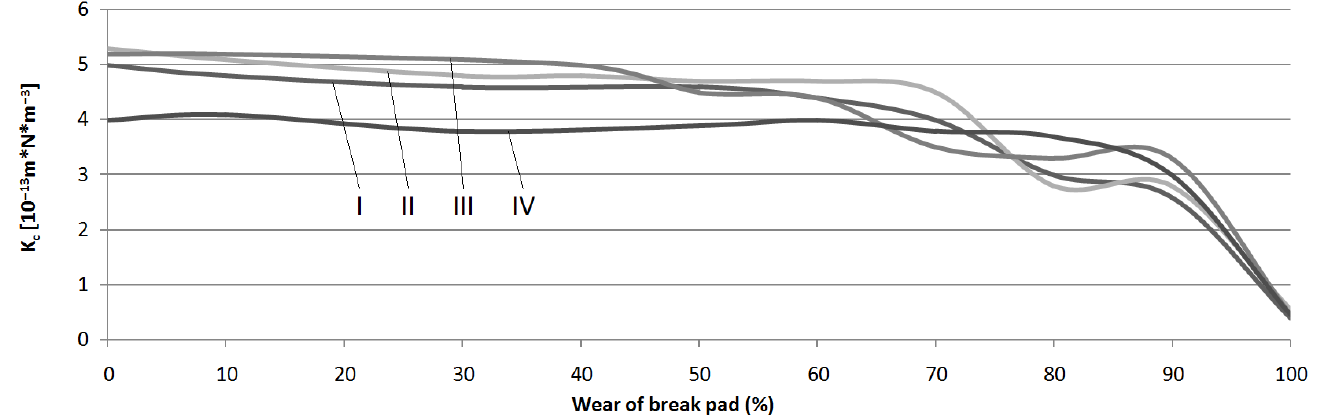
Figure 13. Friction wear rate values in all samples.